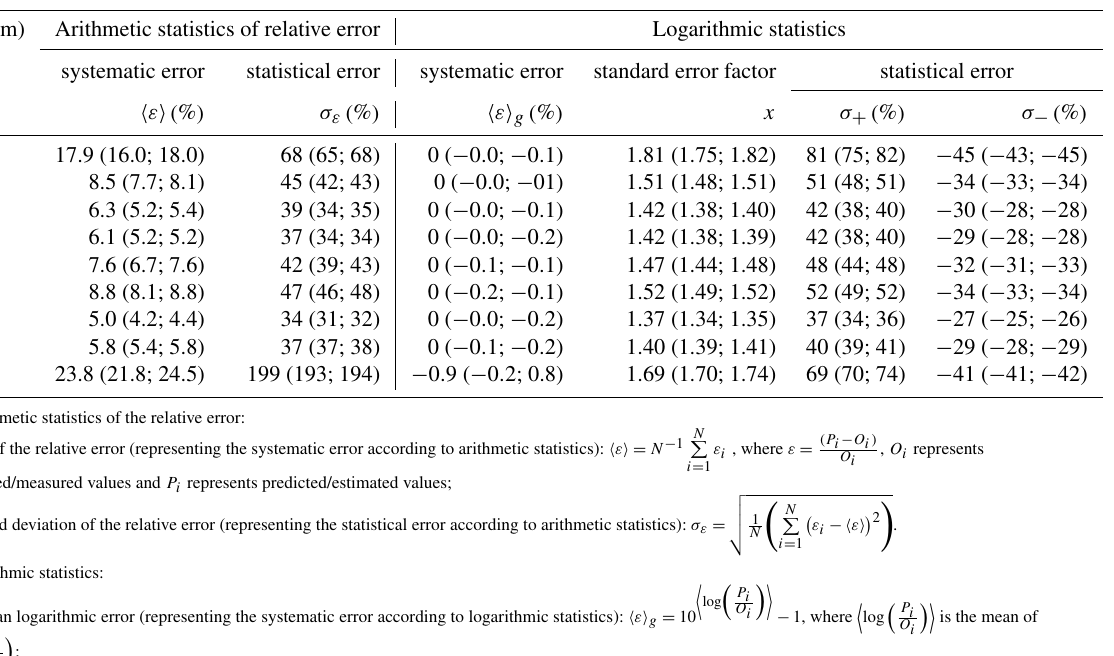
Table 3. Statistics of estimation errors ∗ of coefficient a ph (λ) in selected spectral bands when the different variants of the parameterization derived in this study were applied to the entire dataset ( n = 1002). The calculated values are given for three scenarios: when the general variant of the one-component parameterization was used; when variants specific to individual months were chosen (the first alternative value is given in parentheses); and when the two-component parameterization was used (the second alternative value is given in